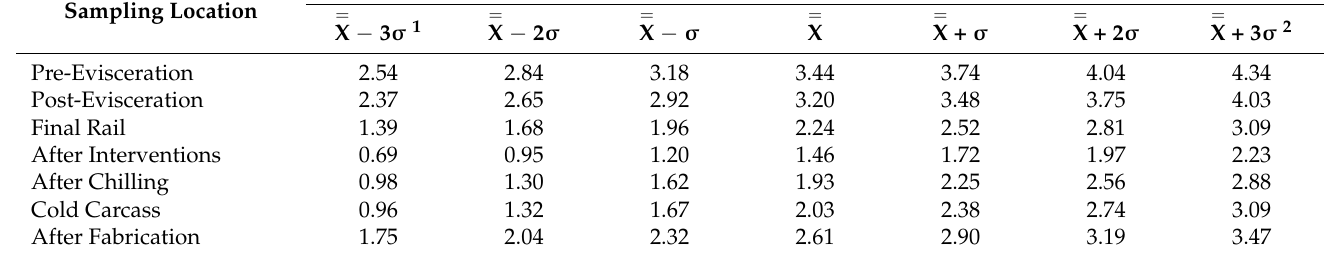
Table 2. Statistical Process Control Parameters for Aerobic Plate Counts (Log CFU/cm 2 ) at different sampling locations on the beef processing line. (n = 12 swabs/location collected during 8 different sampling